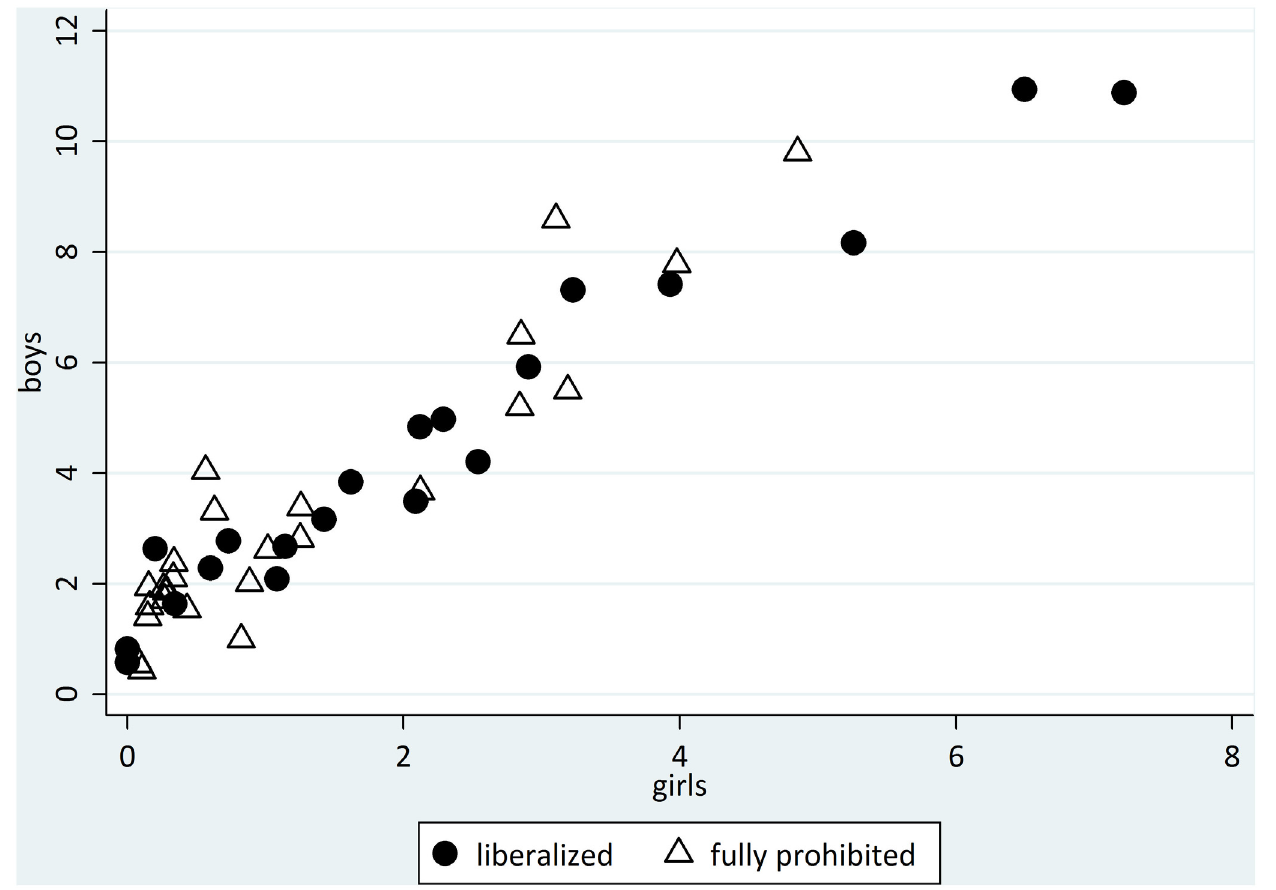
Fig 1. Scatter plot of prevalence of regular cannabis use, by gender and cannabis liberalization status (%). HBSC 2001 – 2010 (N = 172,894).